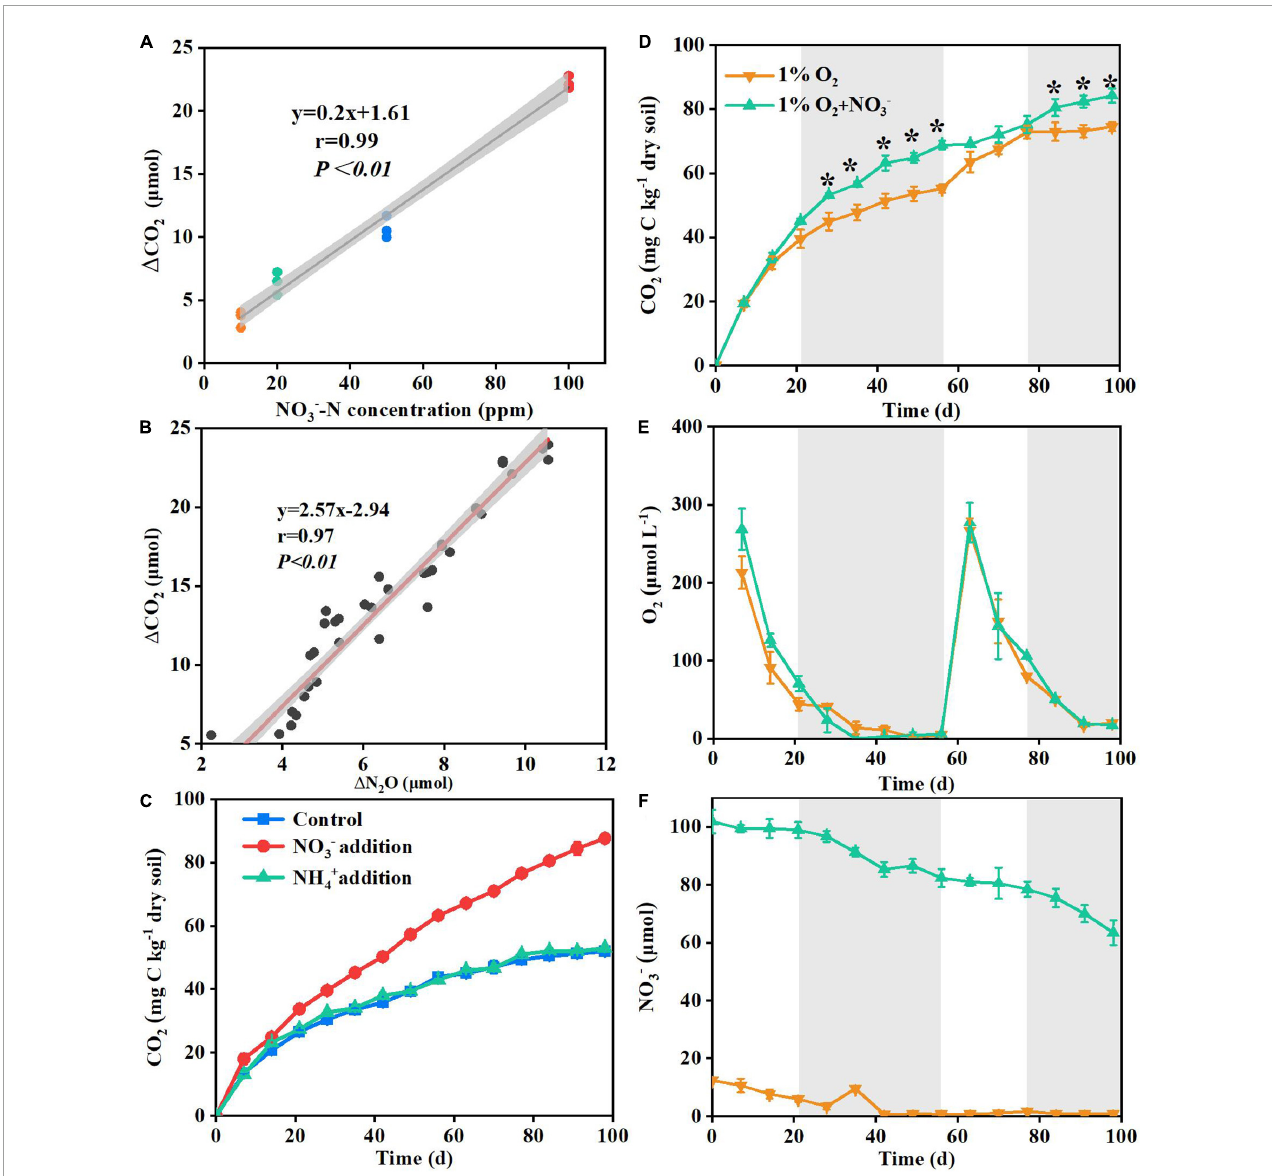
FIGURE2 Correlation between the rate of the supplemented nitrate and the increasing concentration of (cid:49) CO 2 under the nitrate addition treatment in Experiment 2 (A) ; correlation between the increasing amounts of the produced (cid:49) CO 2 and (cid:49) N 2 O at 100 ppm NO 3 – -N treatment in Experiment 2 (B) ; ammonium versus nitrate addition effects on the cumulative CO 2 emissions from deep soil in Experiment 3 (C) ; dynamics of CO 2 (D) , O 2 (E) and NO 3 – (F) concentrations in flasks under 1% O 2 and 1% O 2 + NO 3 – treatments in Experiment 4. Delta indicates the value of nitrate addition treatment minus non-nitrate control within each sampling day. The gray areas in panels (A,B) indicate 95% confidence intervals. The gray areas in panels (D–F) indicate anaerobic conditions with O 2 concentrations below 100 µ mol L – 1 . Asterisk denotes significant difference ( P < 0.05) between the two treatments. Data are shown as the mean ± standard deviation ( n =